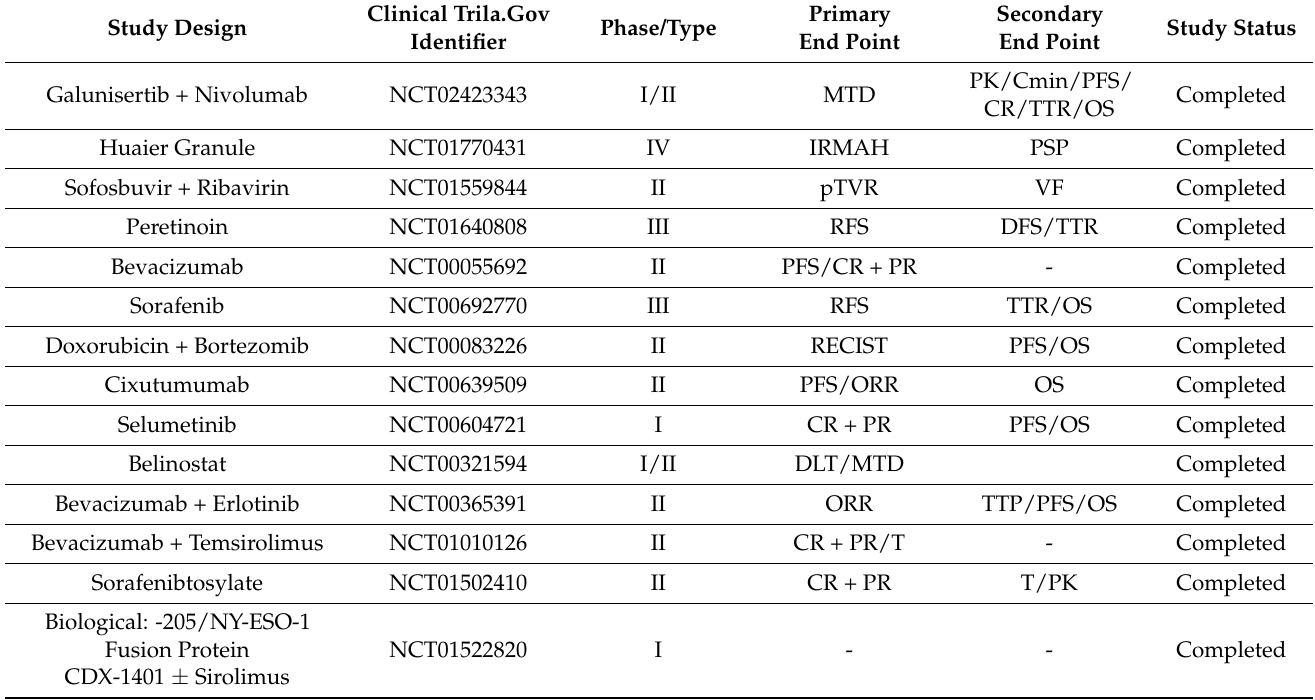
Table 1. Clinical trials on targeted therapy in hepatocellular carcinoma